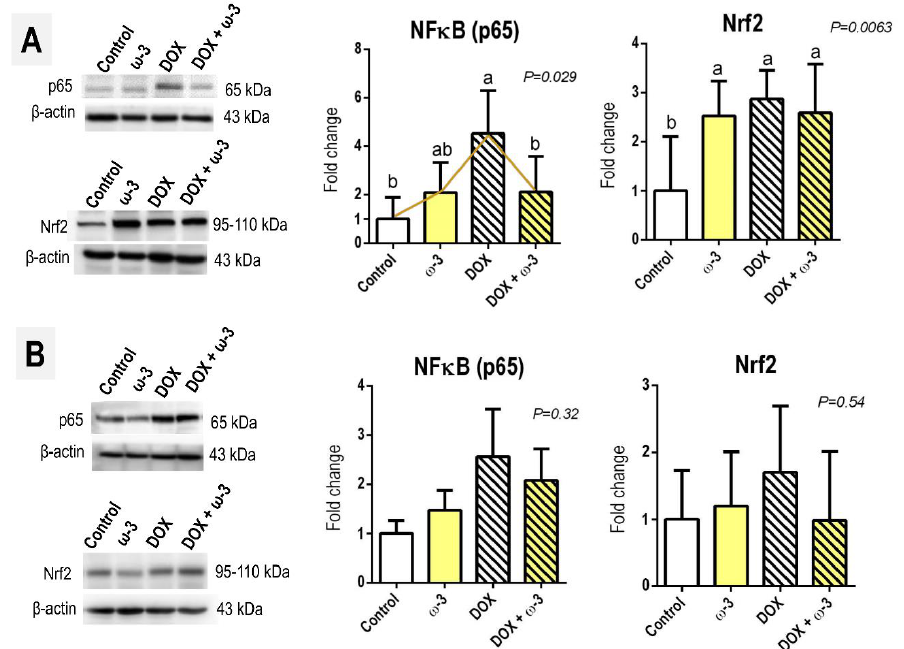
Figure 4. Effects of omega 3 (ω-3) supplementation on doxorubicin (DOX)-induced effects on hepatocyte proliferation (Ki-67). Representative photomicrographs are presented [scale bar: 40 µm] Data are presented as box plots. N = 7 rats/group. Male Wistar rats received ω-3 (400 mg/kg body weight/day) by intragastrical administrations for six weeks (or vehicle). After two weeks of ω-3 supplementation, animals received weekly single intraperitoneal injections of DOX (3.5 mg/kg body weight) for four weeks (or vehicle). The different letters correspond to the statistical difference among groups by Kruskal-Wallis followed by a posteriori Tukey test ( p < 0.05). Vectors (yellow) interconnecting the medians depict the statistical modulation of DOX-induced effects by ω -3.